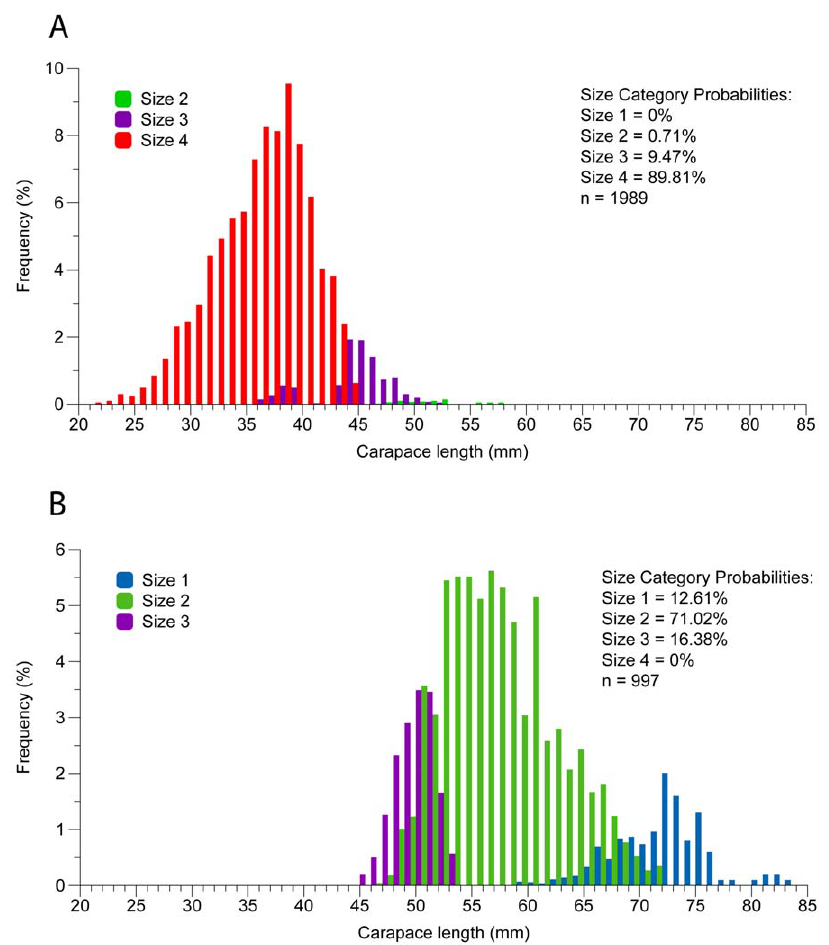
Figure 3. Size structure of the landings. Size frequency distribution (in percentage) of trawl (A) and creel (B) catches, including size probabilities for each size category. Trawl catches are composed of small individuals while creel catches are composed of large individuals. Ninety percent of the trawl catches are traded in size category 4 (lowest value) and category 1 (highest value) is absent. On the other hand, 13% of the creel catches are sold in size category 1, while 71% are in size category 2 and 16% in size category 3. The size distributions for each size category were sampled at the Vila Real de Santo Anto´nio fish auction and result from the onboard separation of the catch.